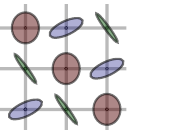
Figure 3: The product ground state phase diagram according to Papanicolaou [ 4 ] . In counter- clockwise order starting at θ = 0 we have the antiferromagnetic (AFM), semi-ordered (SO), ferromagnetic (FM) and ferroquadrupolar (FQ) phases. The SU(3)-symmetric points are marked with black dots.